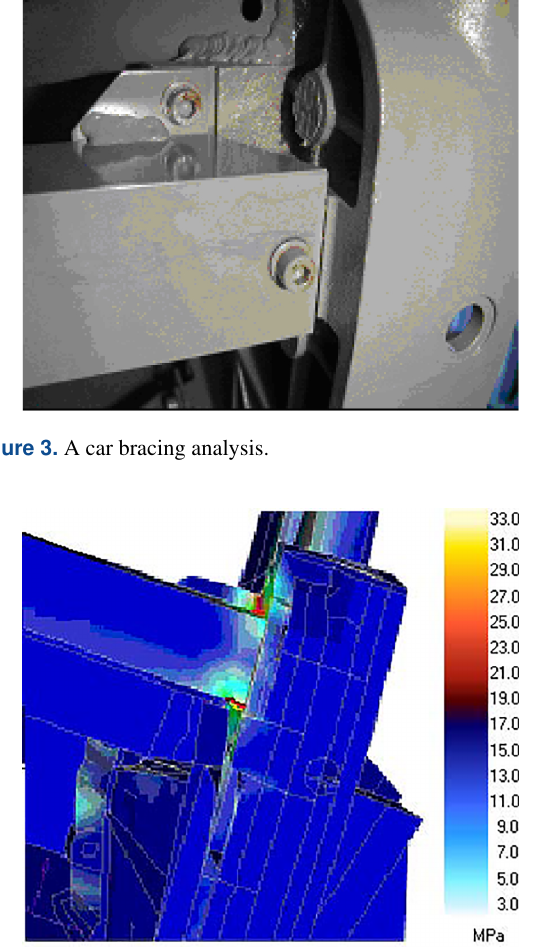
Figure 4. Typical FEM